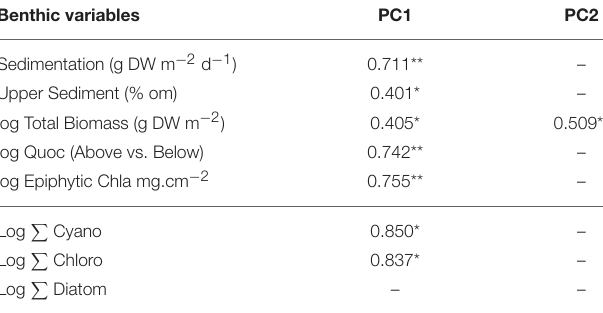
TABLE 3 | Correlation coefficients (R) between descriptors of the benthic environment and scores of the PCA. Benthic